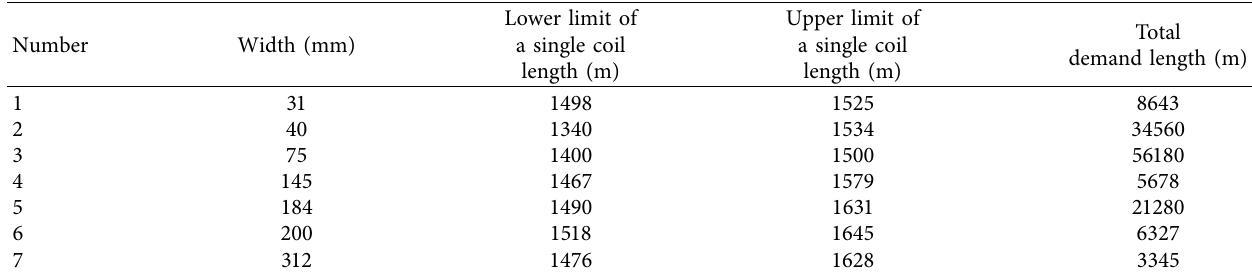
Table 2: Group 2 order.